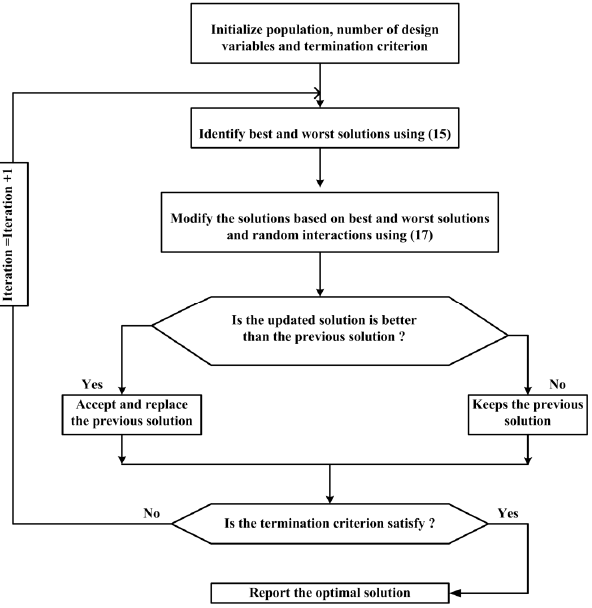
Figure 1. Flowchart of Rao-1 algorithm. Adapted from ref. [29].